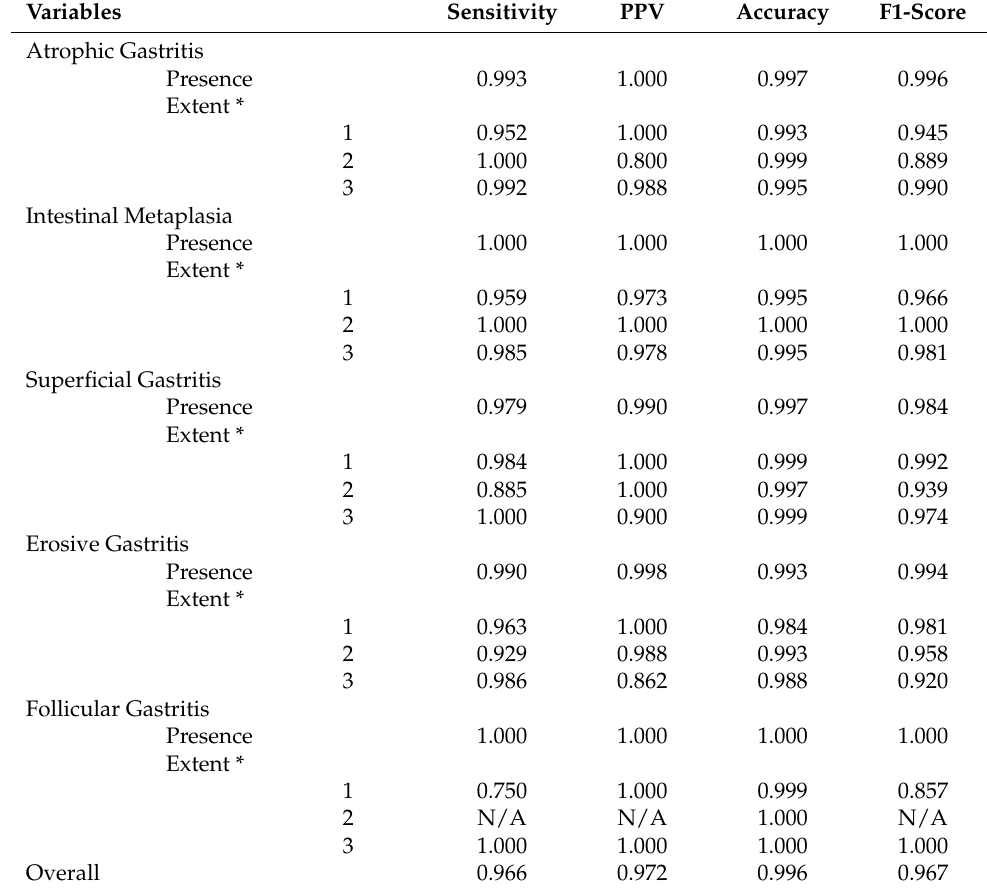
Table 2. Performance of information extraction for gastritis using the NLP pipeline.